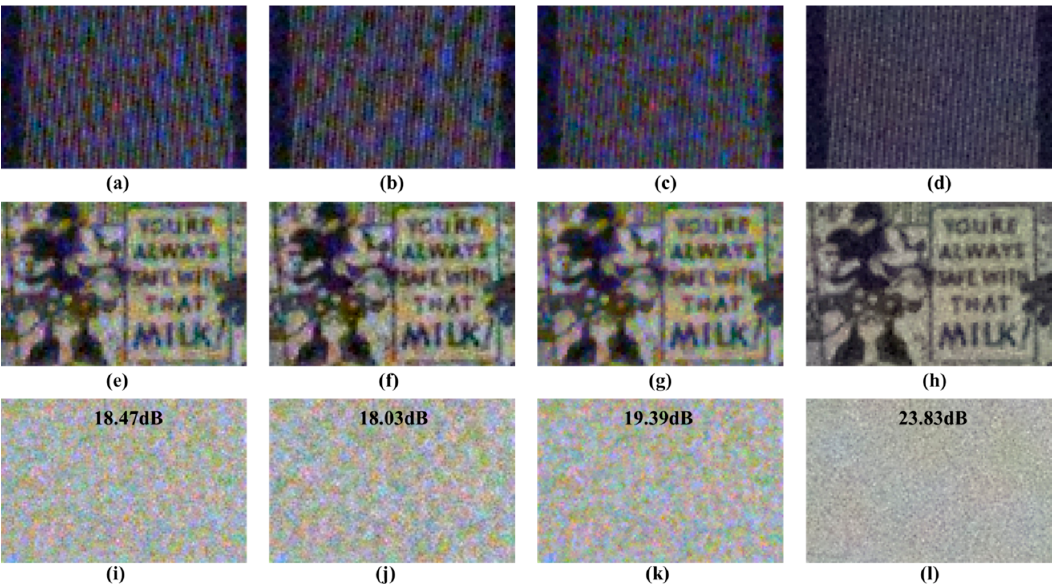
Figure 16. Qualitative and quantitative evaluations comparison of various RGBW demosaicing algorithms: ( a , e , i ) RGB channels of frequency based demosaicing results [25]; ( b , f , j ) RGB channels of pan-sharpening based demosaicing results [26]; ( c , g , k ) RGB channels of multiscale-gradient (MSG)-based demosaicing results [24]; ( d , h , l ) proposed post-processing results.